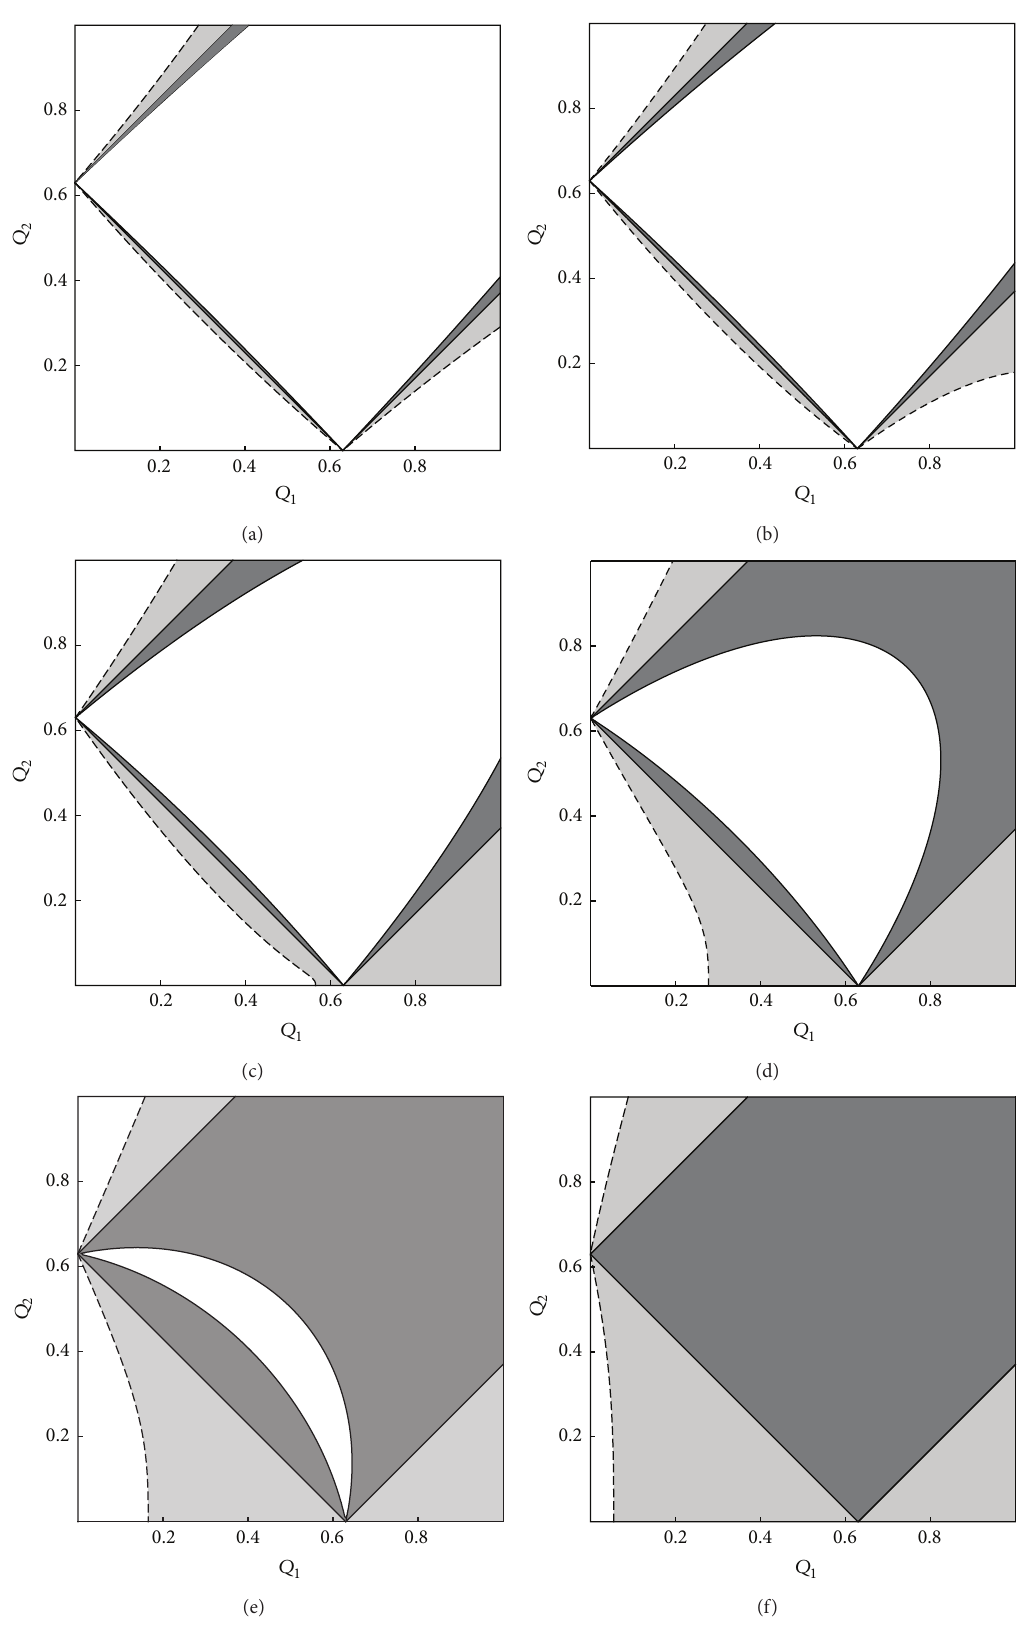
Figure 3: Stability regions of all equilibrium points in the (𝑄 1 , 𝑄 2 ) plane for 𝜔 = 0 . 5 and 𝜇 = 0 . 5, 𝜇 = 0 . 2, 𝜇 = 0 . 1, (from (a) to (c)) 𝜇 = 0 . 05, 𝜇 = 0 . 03, and 𝜇 = 0 . 01 (from (d) to